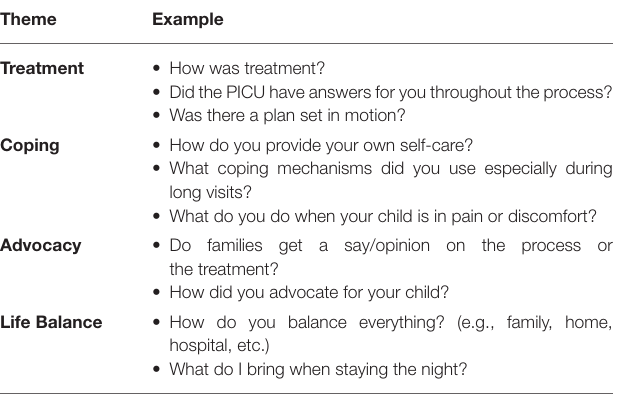
TABLE 3 | Areas of advice families desired from PMs